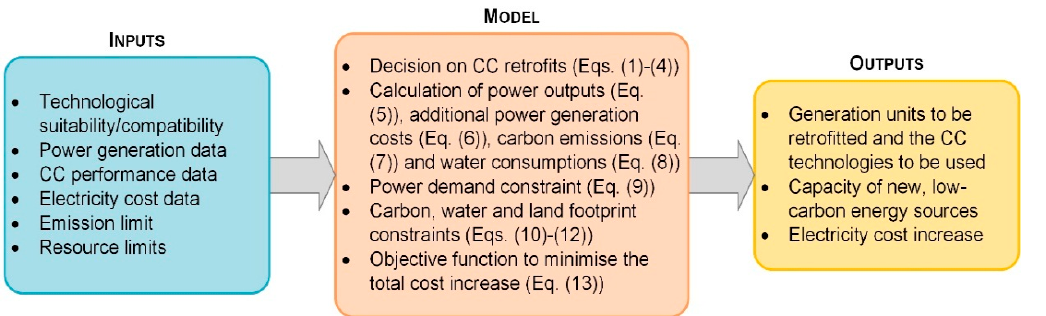
Figure 1. Structure of the developed MILP